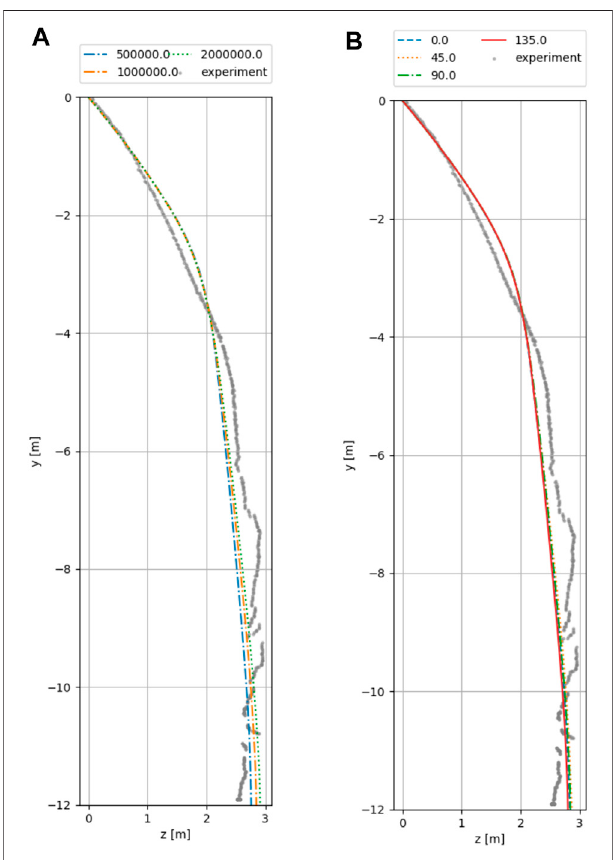
FIGURE 11 | Visualization of object path for varying parameters for T092. (A) Young ’ s Modulus [ N / m 2 ] . (B) Angular reference orientation [ + ] .